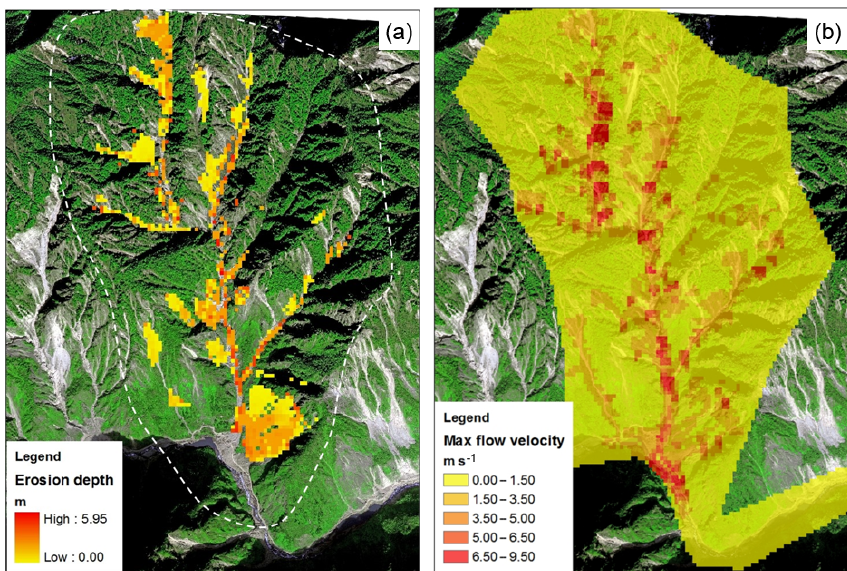
Figure 10. Simulation results of the Xiaojiagou debris flow: (a) final shape and depth of the erosion zone; (b) maximum flow velocity.